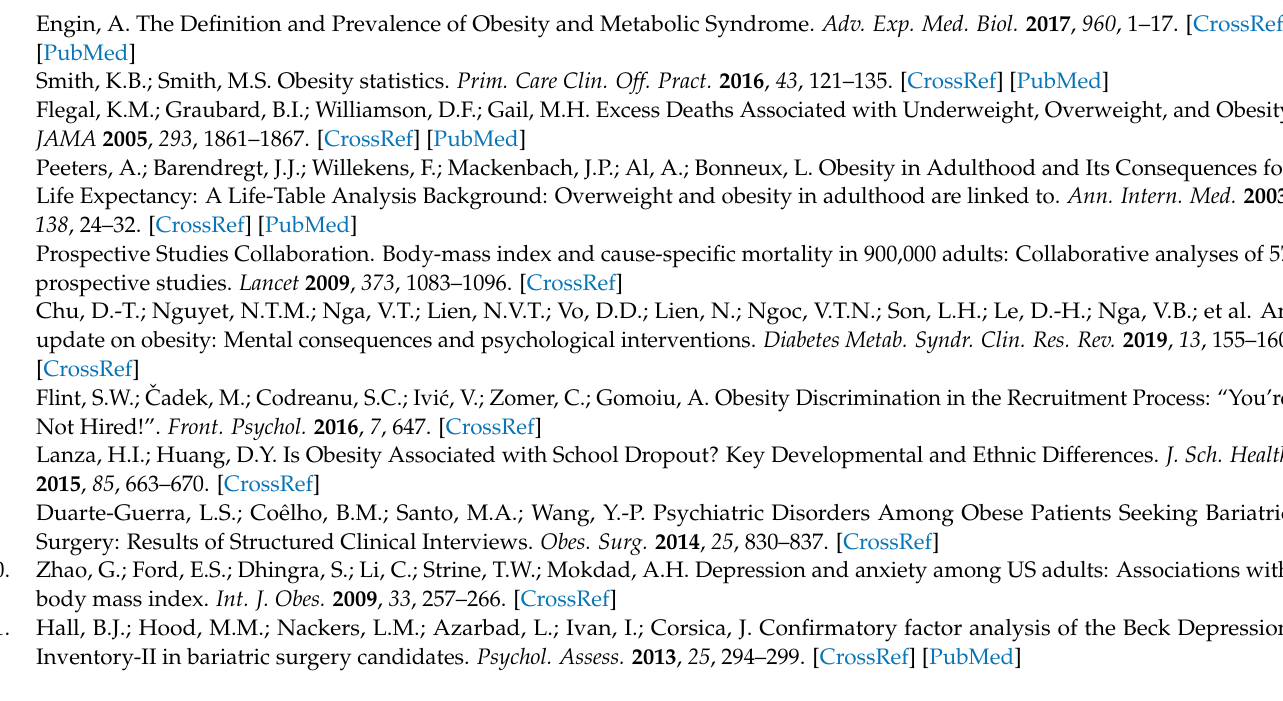
metric Measures. Table S2: The role of gender in the interactions between Psychometric